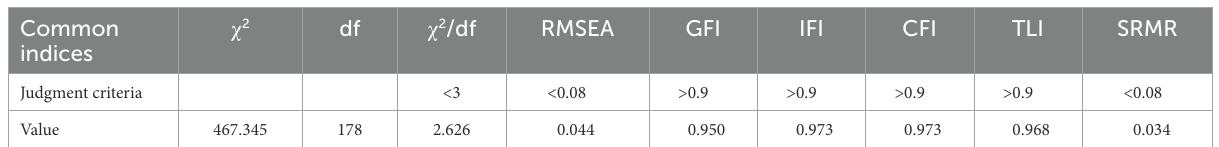
TABLE 11 Adaptability of